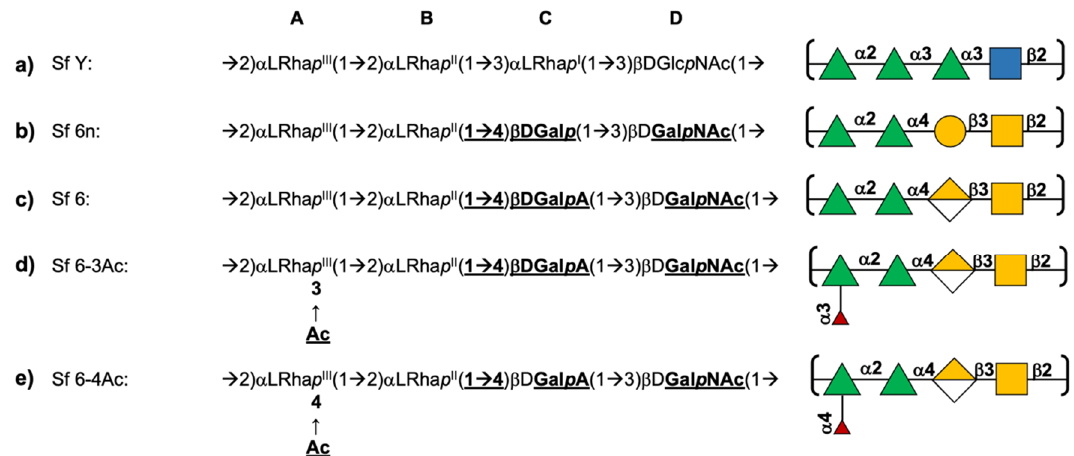
Figure 1. Primary line structures (differences between serotypes shown in bold) and schematic diagrams of the O-antigen repeating units of S. flexneri modelled in this work: ( a ) serotype Y (Sf Y), ( b ) non-biological serotype 6n (Sf 6n) with Gal instead of GalA, ( c ) serotype 6 (Sf 6), ( d ) serotype 6 with 100% O-acetylation at O3 of Rha III (Sf 6-3Ac), and ( e ) serotype 6 with 100% O-acetylation at O4 of Rha III (Sf 6-4Ac). Diagrams use the Symbol Nomenclature for Glycans (SNFG) [12,13] with green triangle for Rha, blue square for GlcNAc, blue circle for Glc, yellow circle for Gal, yellow half diamond for GalA, yellow square for GalNAc, and red triangle for O-acetyl.